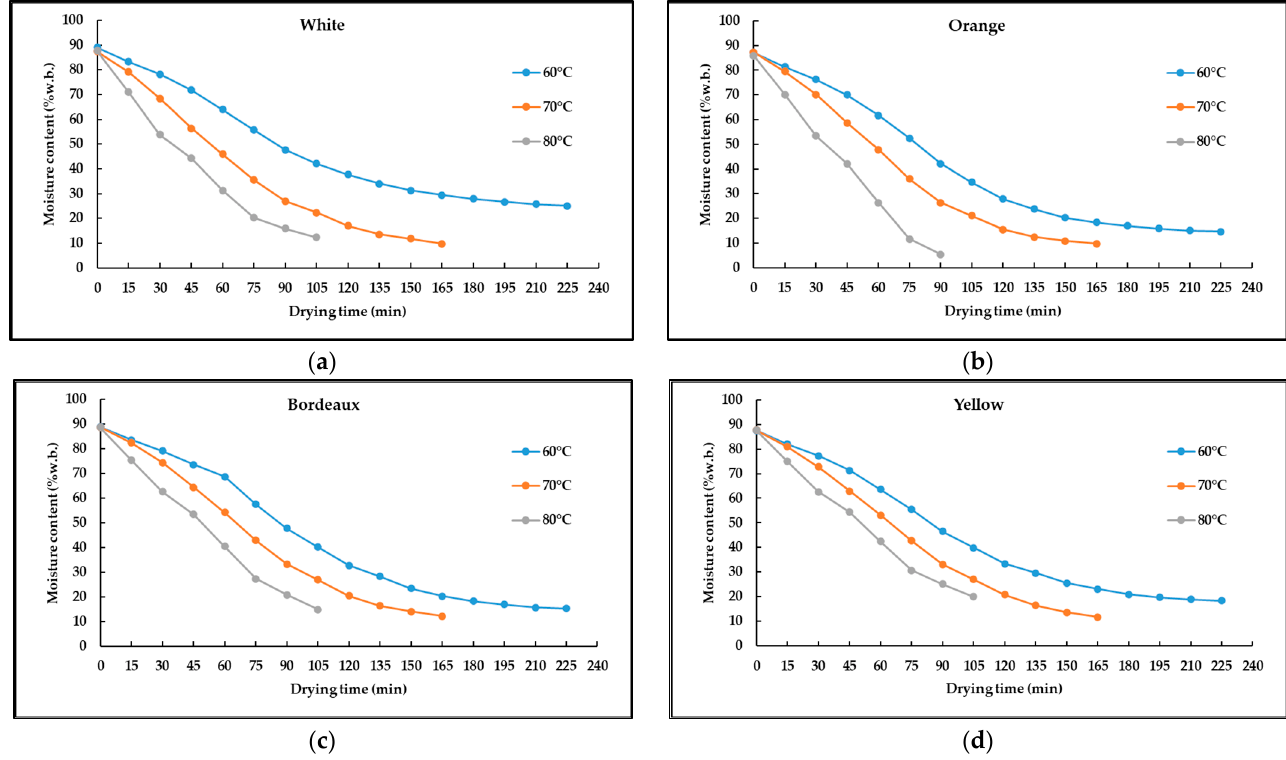
Figure 1. The effect of different drying air temperatures on the drying time of different colored flowers ( a ) white, ( b ) orange, ( c ) bordeaux, and ( d ) yellow pansies. Drying is a food preservation technique that prevents microbial spoilage and slows down enzymatic activity by removing moisture from foods. Generally, foods that contain 25% moisture content or below are considered dried foods [52]. Although the safe moisture content range for dried products is accepted as 10% (w.b.) [53], it was observed that some samples reached equilibrium moisture content at higher moisture content. Bae and Lee [54] reported that 23 ± 1% moisture content was obtained in Chrysanthemum boreale M. flowers dried in a hot air dryer at 40, 50, and 60 ◦ C. Our results are also in agreement with [55] using infrared drying and solar drying [56] of rose petals. The average moisture contents obtained at different drying temperatures in this study showed that bordeaux pansies had the lowest moisture content, followed by orange, yellow, and white pansies, respectively. 30–50 µ m Hg) and three levels (27, 37, and 47 ◦ C) of vacuum drying were applied to